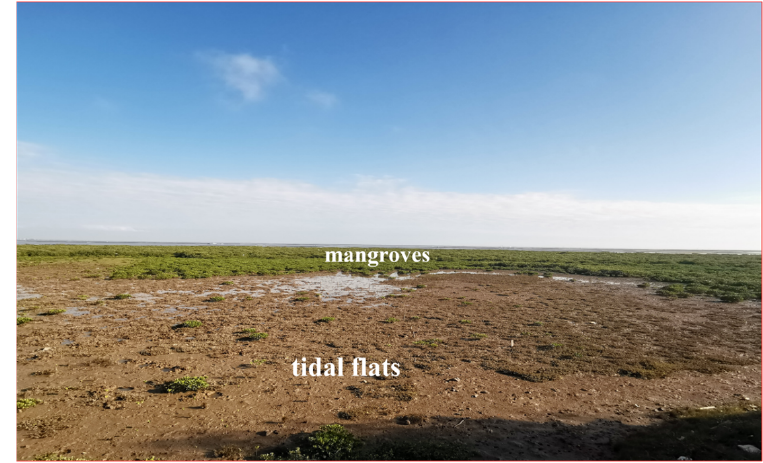
Figure 6. Photo of tidal fl ats and mangroves in the study